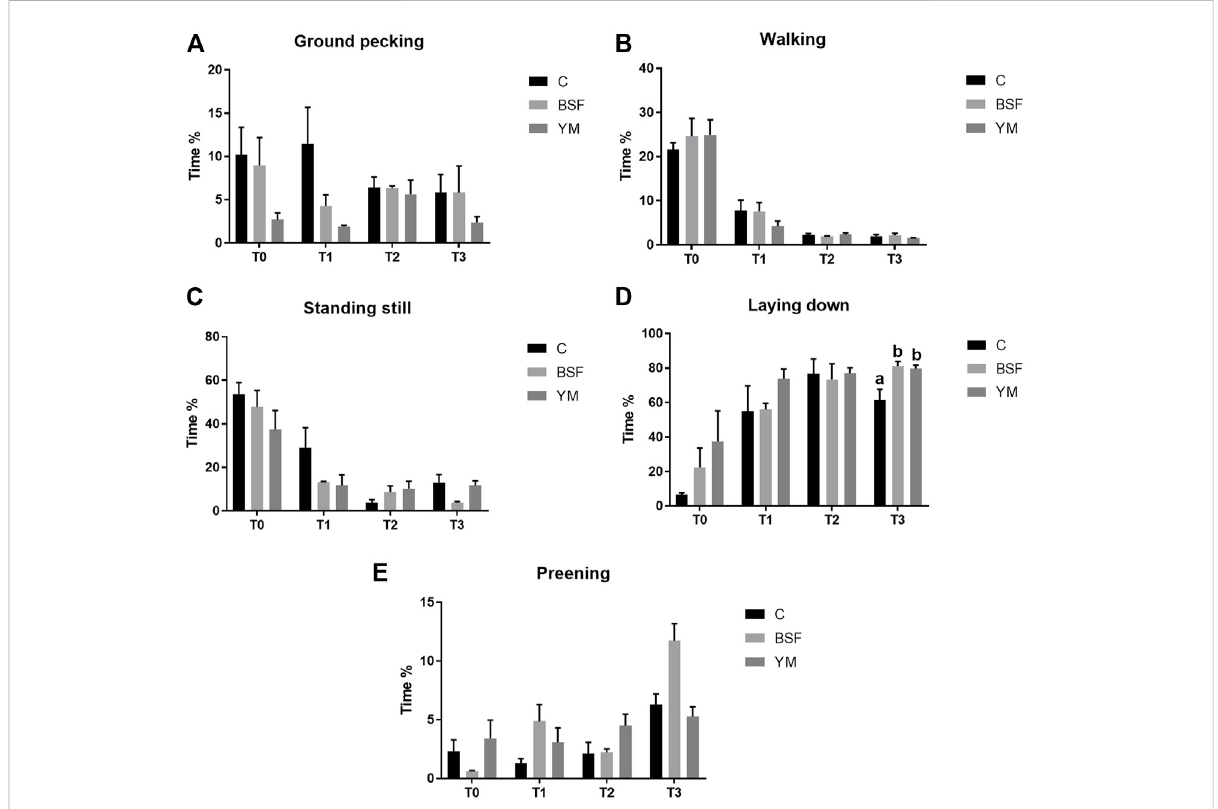
FIGURE 6 Duration behaviours of the broiler chickens in the afternoon (diet*time interaction). (A) Preening. (B) Allopreening. (C) Stretching. (D) Wing fl apping. (E) Shaking. Graph bars (representing least square means) with different superscript letters (a, b) indicate signi fi cant differences among the experimentaltreatmentswithintheexperimentaltimes.C=controlgroup;BSF=Cdiet+blacksoldier fl ylivelarvae;YM=Cdiet+yellowmealworm live larvae. T0 = day 0; T1 = day 11; T2 = day 22; T3 = day 33.